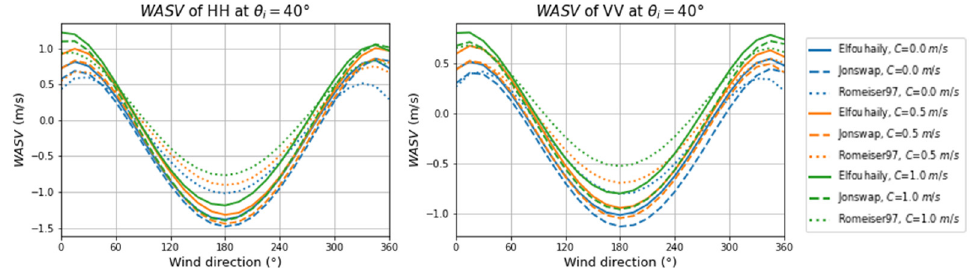
Figure 14. The relationship between WASV and wind direction for different wave spectrum models and current velocities. Wind speed and direction were 10 m/s and 0 ◦ , respectively. Swell amplitude, direction, and wavelength were 0.5 m, 0 ◦ , and 200 m, respectively. The model is indicated by line style: solid line indicates Elfouhaily, dashed line indicates Jonswap, and dotted line indicates Romeiser97. The current velocity is indicated by color.